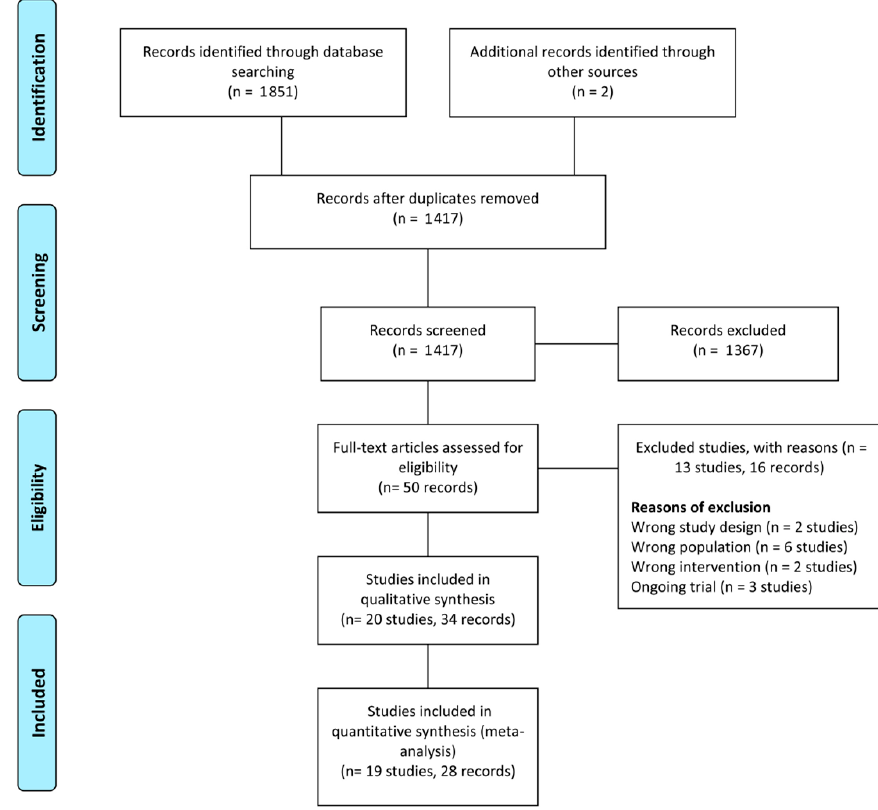
Figure 1. PRISMA flow